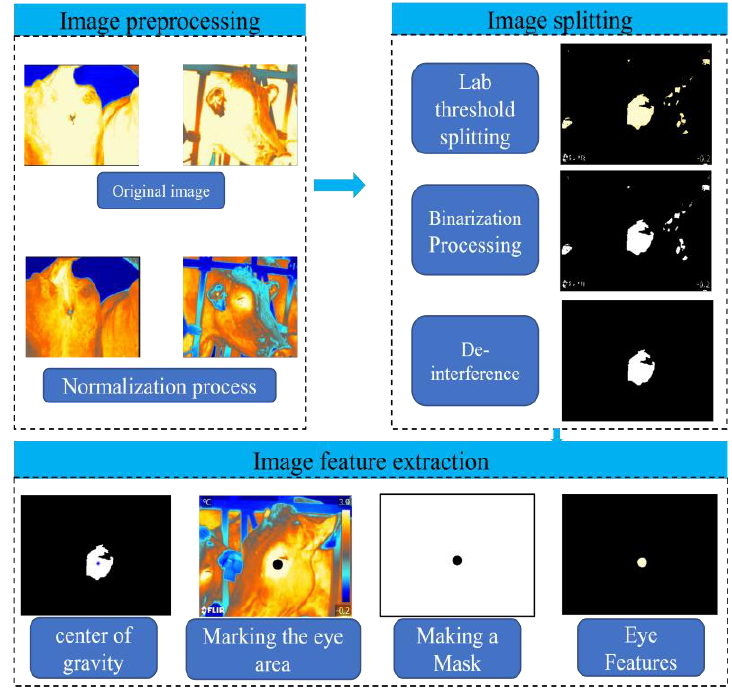
Figure 7. Flow chart of lab-color-space-based image extraction method.